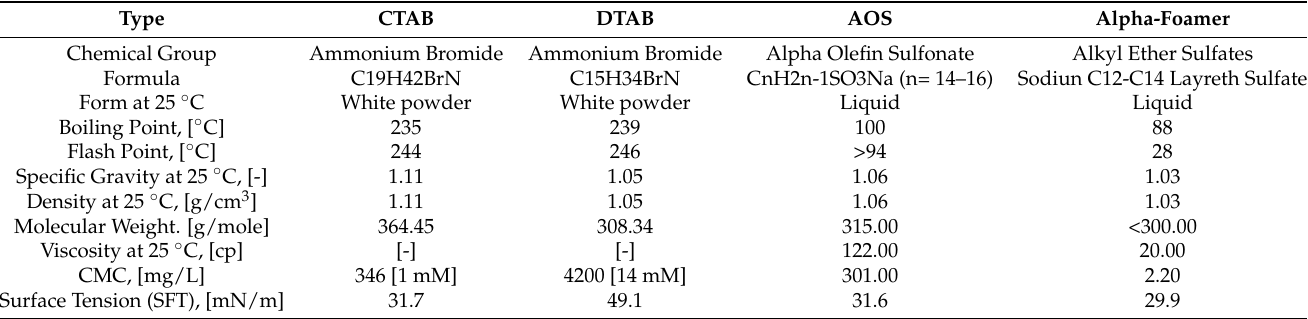
Table 4. Physical properties of the four (i.e., two cationic and two anionic) surfactants investigated in this experiential